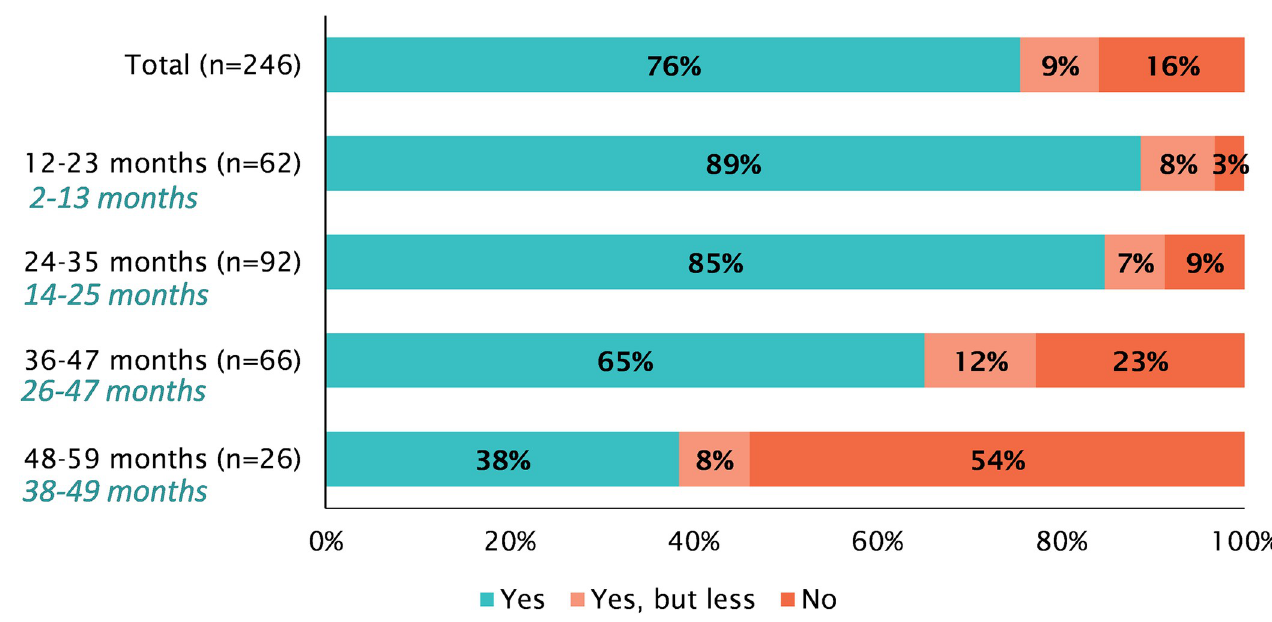
Fig 2. (Dis)continuation of breastfeeding during COVID-19 by caretakers who were breastfeeding prior to the pandemic by age of child on day of the survey and approximate age at the start of the COVID-19